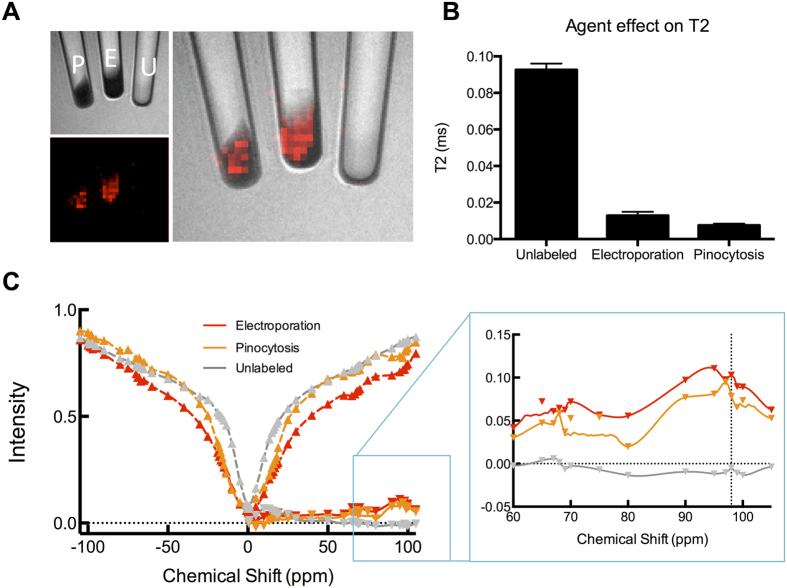
MRI detection of cells labeled via pinocytosis or electroporation.(A) Cells labeled with Yb-HPDO3A via electroporation (530 V, 100 μs pulse to give 9.5 mM pellet) (E) and pinocytosis (100 mM, 24 h to give 10.1 mM pellet) (P) were readily detected whereas unlabeled cells (U) did not produce a significant asymmetry. However, the asymmetry effect of Yb-HPDO3A is markedly attenuated after cell uptake compared to its effect in solution. (B) It was also evident that Yb-HPDO3A induced a dramatic shortening of T2 with a more significant shortening being evident upon pinocytotic incorporation. (C) Electroporation of Yb-HPDO3A showed a more significant asymmetry at 97 ppm than those labeled via pinocytosis. Notably, the asymmetry at 69 ppm was very much reduced. Z spectra were generated using image acquisitions at 66–71 and 95–100 ppm at 1 ppm per step, with reference images at 0 and −300 ppm. The remaining data points were fitted using smoothing splines.